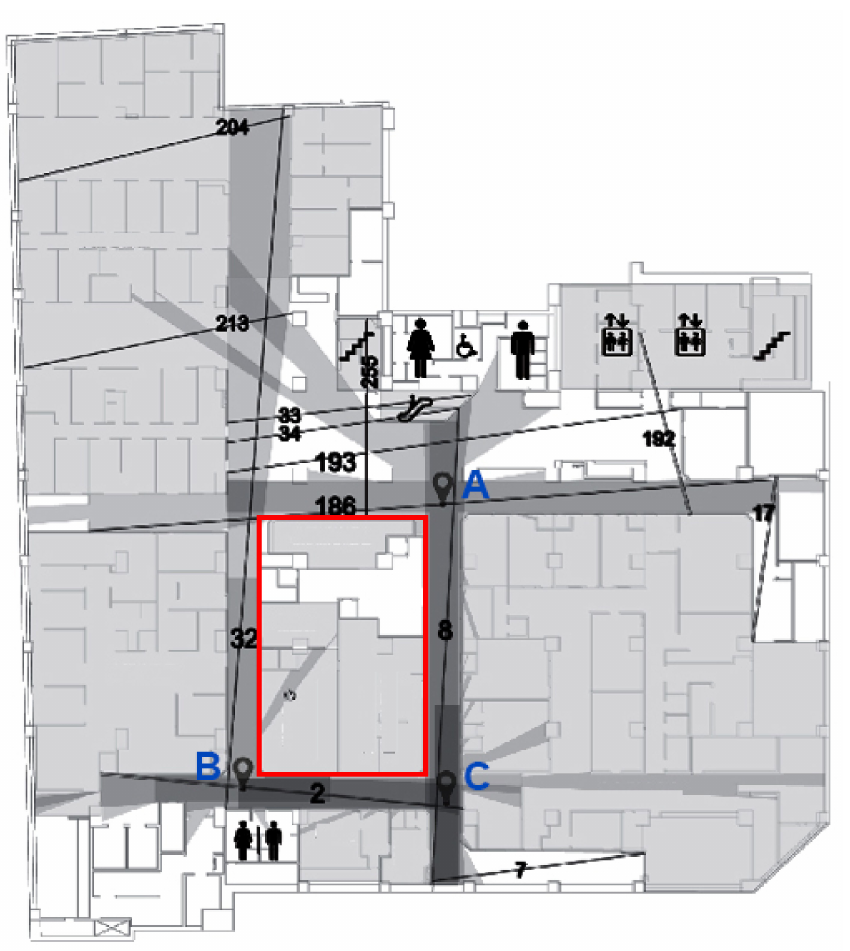
Figure 12. The visual area of the subject location in the intersection area of route numbers 186, 32, 2, and